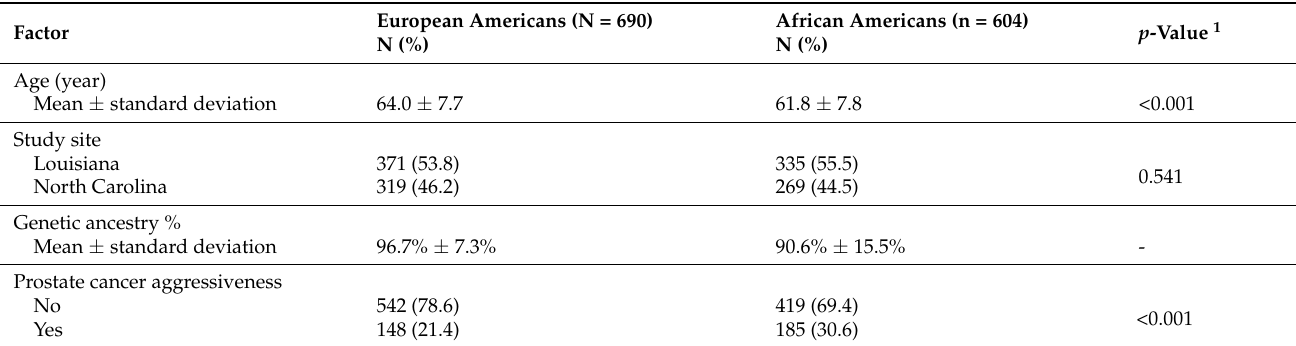
Table 1. Summary of study participants’ age and study